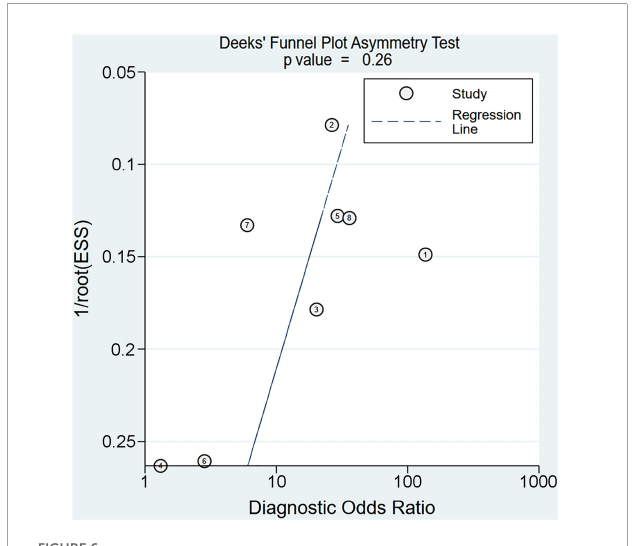
FIGURE6 Deek’s funnel plot asymmetry test for assessment of publication bias across the included studies.